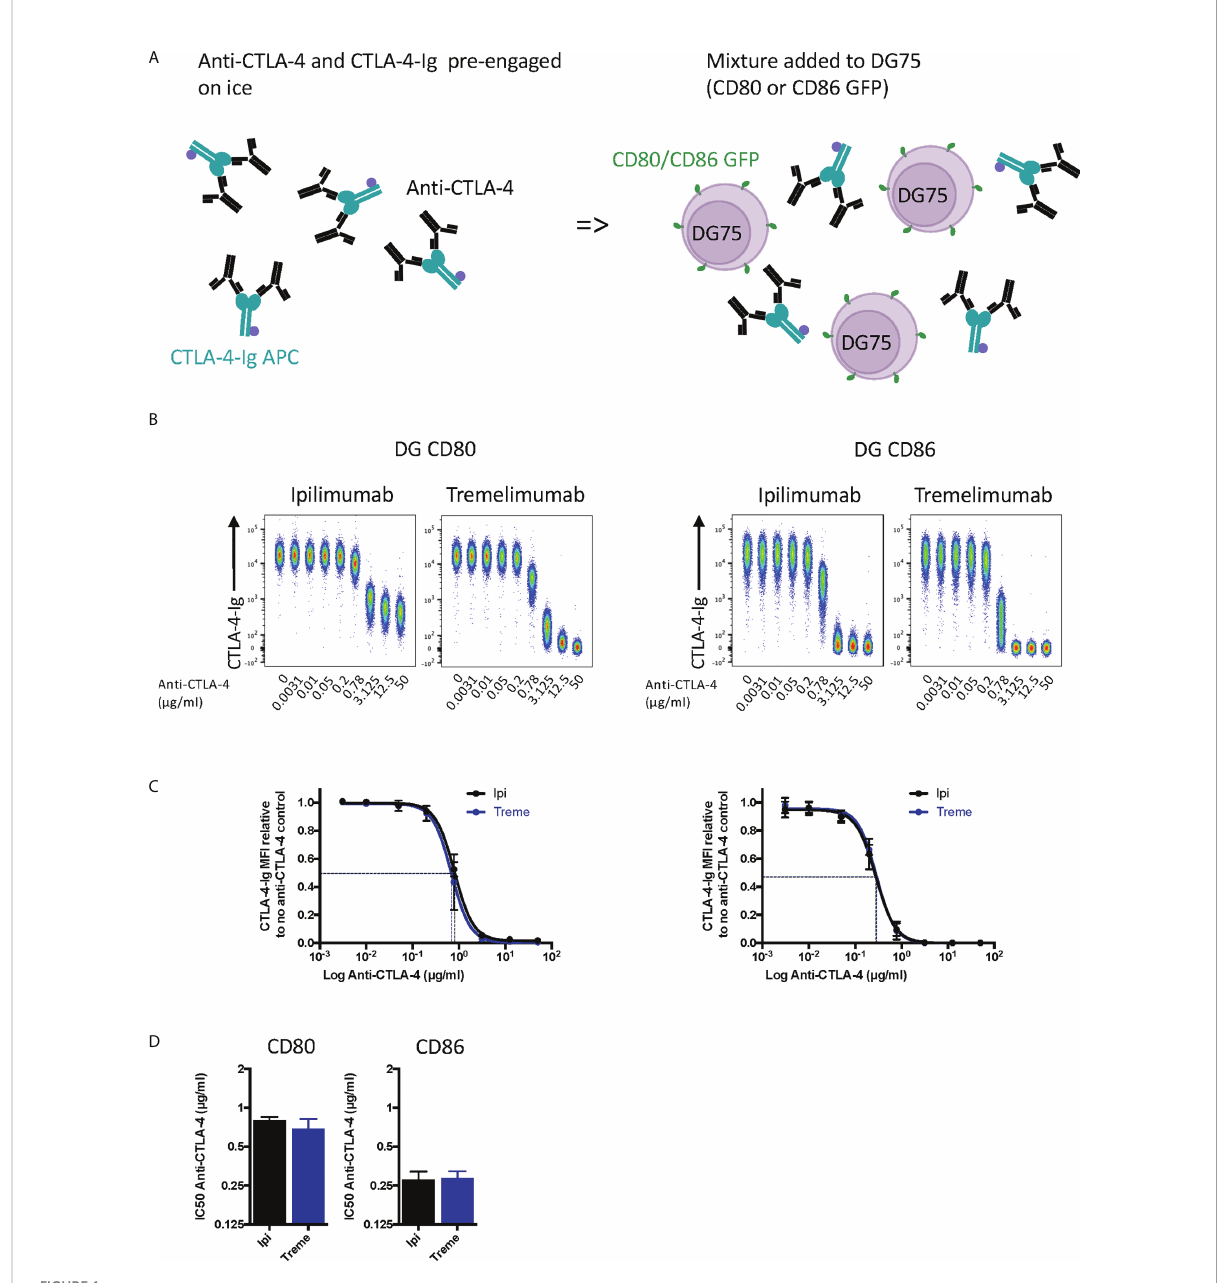
FIGURE 1 Pre-engagement of Ipilimumab and Tremelimumab with soluble CTLA-4-Ig prevents CTLA4 binding to cell bound CD80 or CD86 ligand. (A) Schematic of experimental set-up. A fi xed dose (2µg/ml) of soluble APC conjugated Abatacept was incubated on ice with a titration of soluble anti- CTLA-4 Abs to pre-engage CTLA-4 with anti-CTLA-4. This was added to DG75 B cells expressing either CD80 or CD86-GFP and incubated on ice for 30 minutes. Cells were washed and analysed for Abatacept-ligand interaction by fl ow cytometry. All reagents were chilled on ice before use. (B) Representative concatenated FACS plots show impact of Abatacept-ligand engagement as the dose of anti-CTLA-4 Abs increased. (C) Anti-CTLA-4 doses were Log(x) transformed and dose response curves fi tted using Prism v6 to obtain Log IC 50 for ipilimumab(Ipi) (Black line) and tremelimumab (Treme) (Blue line). (D) Graphs show the mean IC 50 with 95% con fi dence interval calculated using Prism v6. Data for ipilimumab and tremelimumab were acquired in separate 96-well plates and data presented as mean +/- SD from 3 independent